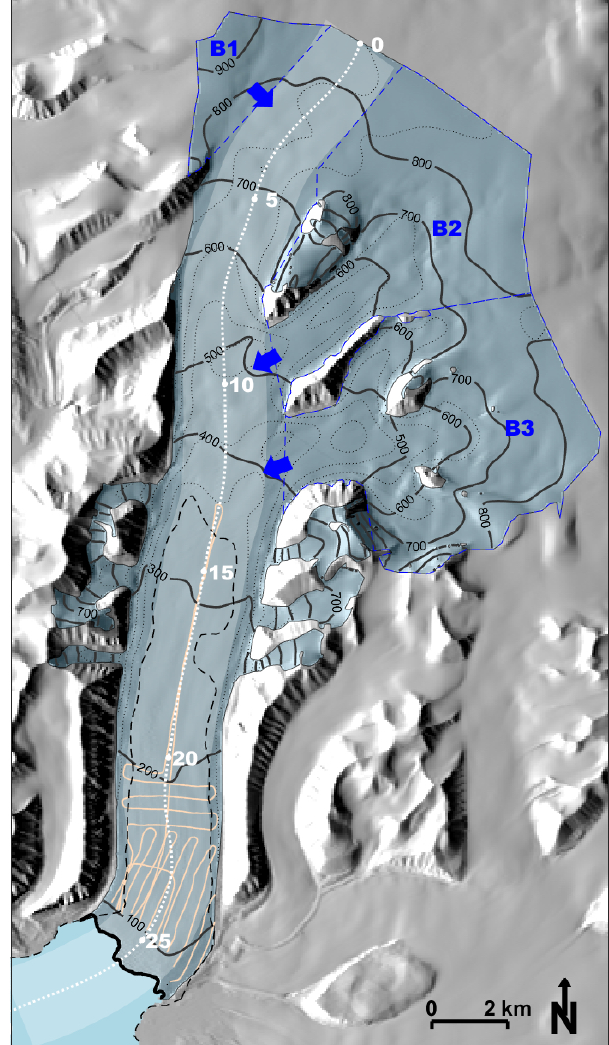
Figure 3. Map of Tunabreen. Surface contours (thick black lines) at 100m intervals are from the NPI S0 DEM (Norwegian Polar Insti- tute, 2014), based on aerial photography from 2009 (lower glacier tongue, 0–450ma.s.l.) and 2011 (upper glacier, > 450ma.s.l.). Bed contours (dotted black lines) at 100m intervals are based on the Fürst et al. (2018) reconstruction in the upper glacier and 2015 helicopter radar (Katrin Lindbäck and Jack Kohler, in Welty et al., 2020) measurements (light-red lines) in the lower glacier. The dashed subglacial contour shows the part of the bed below sea level. The centreline profile (dotted white line) along the 2200m wide main flow band (lighter blue) shows distance from the ice divide at 5km intervals. The three upper basins (dashed blue outlines) supply mass to the main flow band (blue